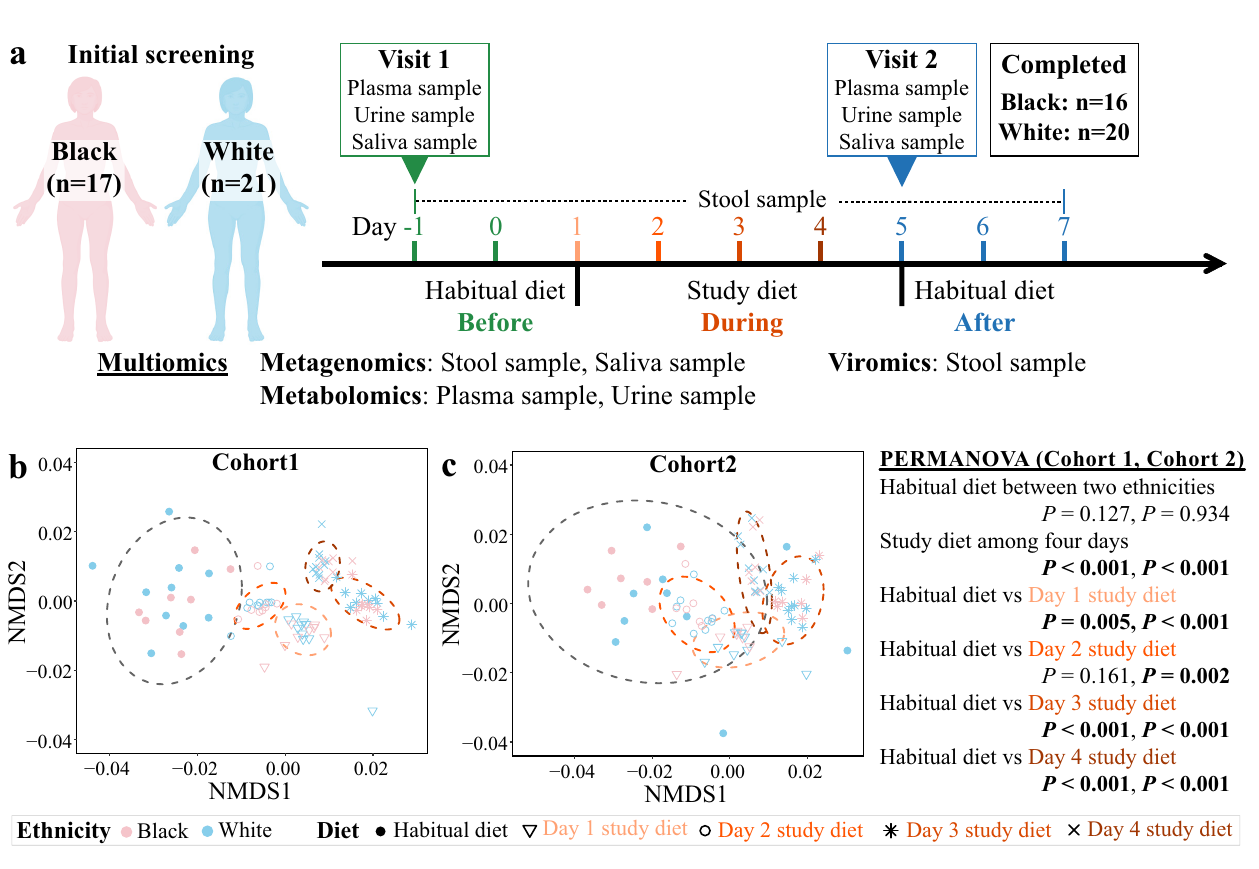
Fig 1. Experimental design and diet profiles. (A) The VMIC study examined short-term longitudinal, multiomic data from multiple body sites over 9 days with 3 broad categories of evaluation (before: habitual diet, days − 1 and 0; during: vegetarian diet, days 1 through 4; after: habitual diet, days 5 through 7). (B, C) Nutrient profiles inclusive of macro- and micronutrients (normalized by kcals) of the habitual diet and daily, vegetarian, study diets (Data underlying plot B and C can be found at S1 Data) are shown by NMDS ordination analysis based on Euclidean distance and statistically compared for significant differences by PERMANOVA. Human cliparts in plot A were created with BioRender.com. NMDS, nonmetric multidimensional scaling; PERMANOVA, permutational multivariate analysis of variance; VMIC, Vanderbilt Microbiome Innovation